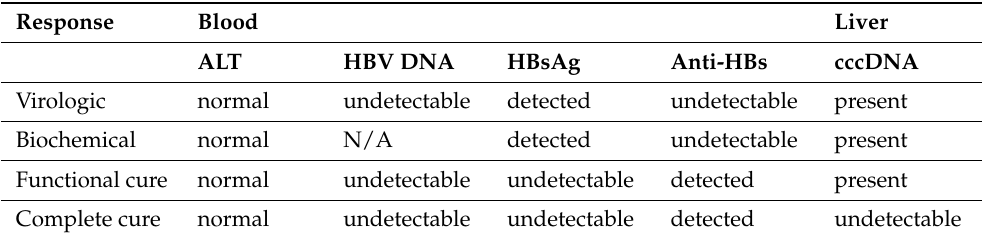
Table 1. Goals and definitions for HBV